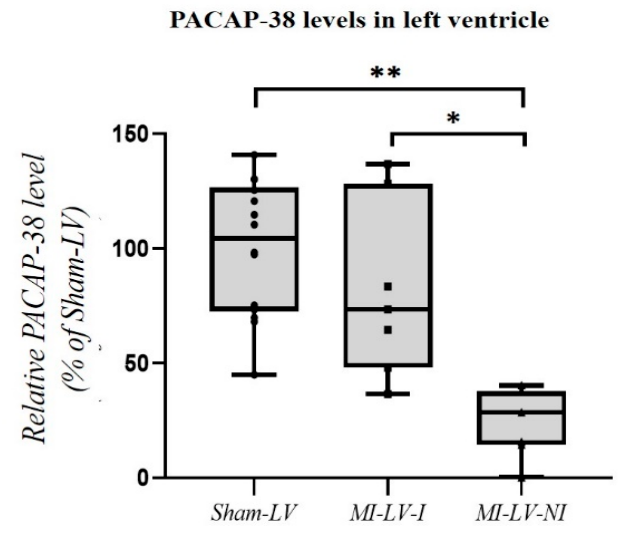
Figure 2. Differences between the tissue PACAP-38 levels in left ventricle in Sham-operated animals (Sham) and after myocardial infarction (MI) with time matched three-hour reperfusion. PACAP-38 level was significantly reduced in the non-ischemic left ventricular samples of MI hearts compared to the ischemic LV samples and also to the Sham hearts. Data are expressed in ratio of Sham-LV PACAP-38 level. The boxes show the interquartile ranges, and the whiskers indicate the most extreme observations. The middle line within the boxes represents the median values. Individual values are presented as black dots and squares. One-way ANOVA with Tukey’s post hoc test, * p < 0.05, ** p < 0.001 vs. Sham group. n = 7 (From each animal, two determinations were performed from 2 different region of the left ventricle (in case MI-LV: ischemic (MI-LV-I) and non-ischemic region (MI-LV-NI)/heart, in case Sham-LV: 2 regions equivalent to the MI-LV-I and MI-LV-NI regions/heart).